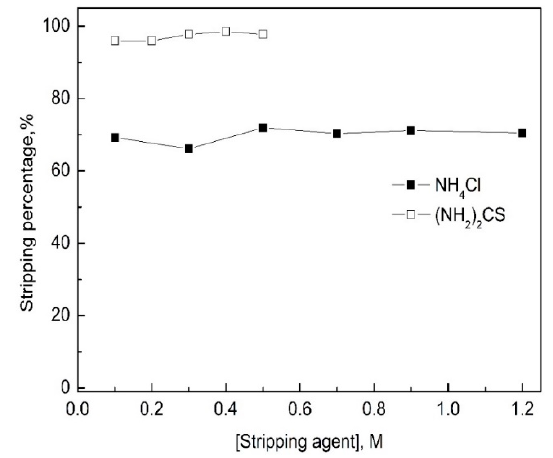
Figure 3. Stripping of Au(III) from the loaded Cyanex 272 by different stripping agents. ((Cyanex 272) = 0.2 M, Loaded (Au(III)) = 99.9 mg/L, (NH 4 Cl) = 0.1–1.2 M, ((NH 2 ) 2 CS) = 0.1–0.5 M).